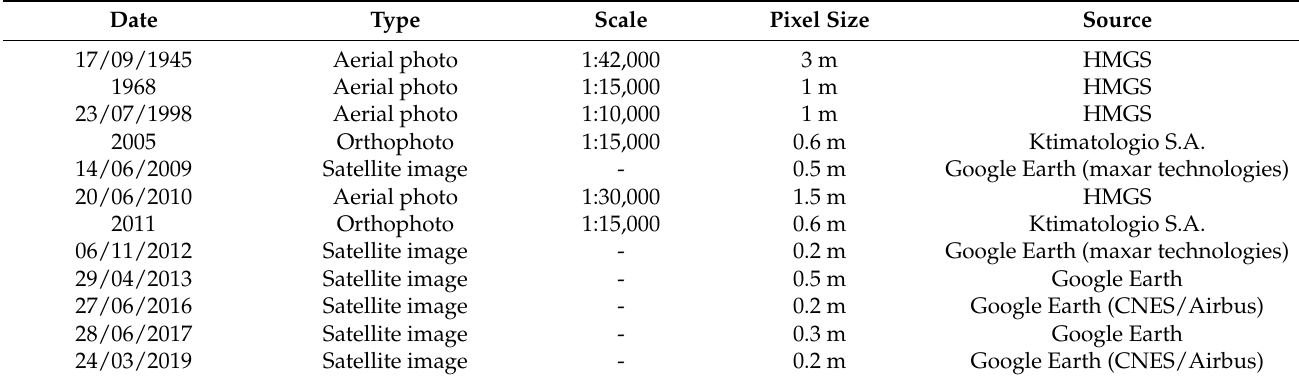
Table 1. Date, type, scale, resolution, and source of the images used for coastal evolution